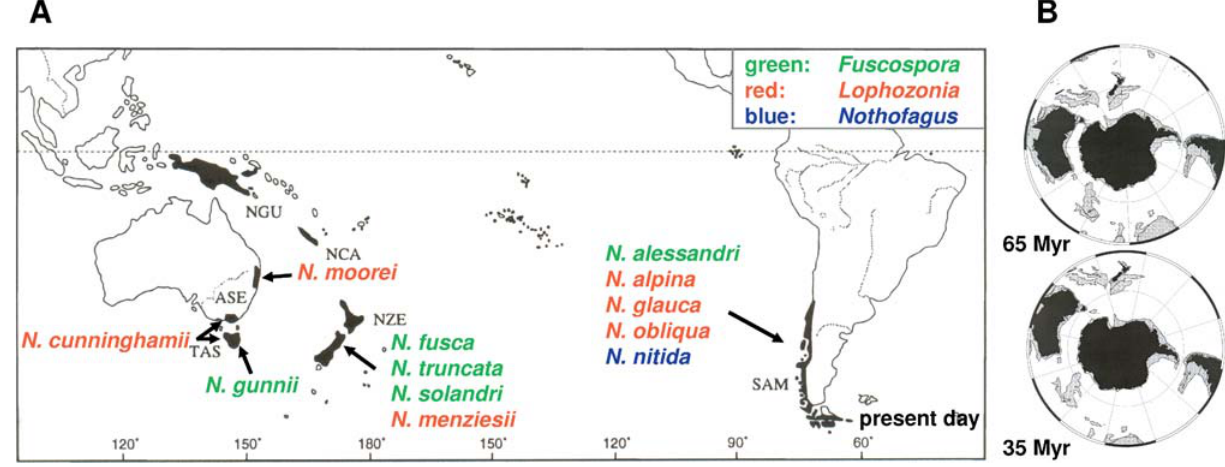
Figure 1. Southern Hemisphere Maps and Present-Day Nothofagus Distribution (A) Transoceanic distribution of Nothofagus subspecies Lophozonia and Fuscospora and South American species N. nitida (subgenus Nothofagus ). Map adapted from Swenson et al. [43]. ASE, Australia; NCA, New Caledonia; NGU, New Guinea; NZE, New Zealand; SAM, South America; TAS, Tasmania. (B) Relationship of Australia, New Zealand, and South America 65 Myr and 35 Myr before present, reconstructed from http://www.odsn.de/ (link ‘‘ Plate Tectonic Reconstructions ’’